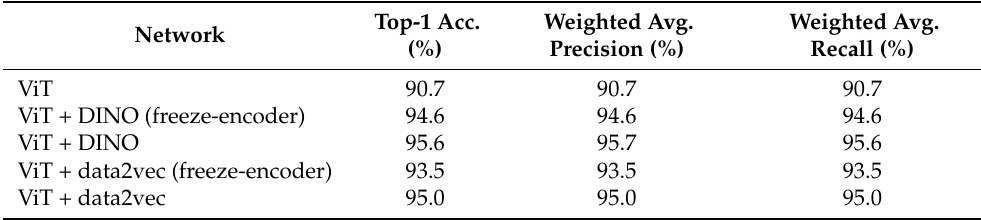
Table 2. Comparison of classification performance by different ViT training settings. Network